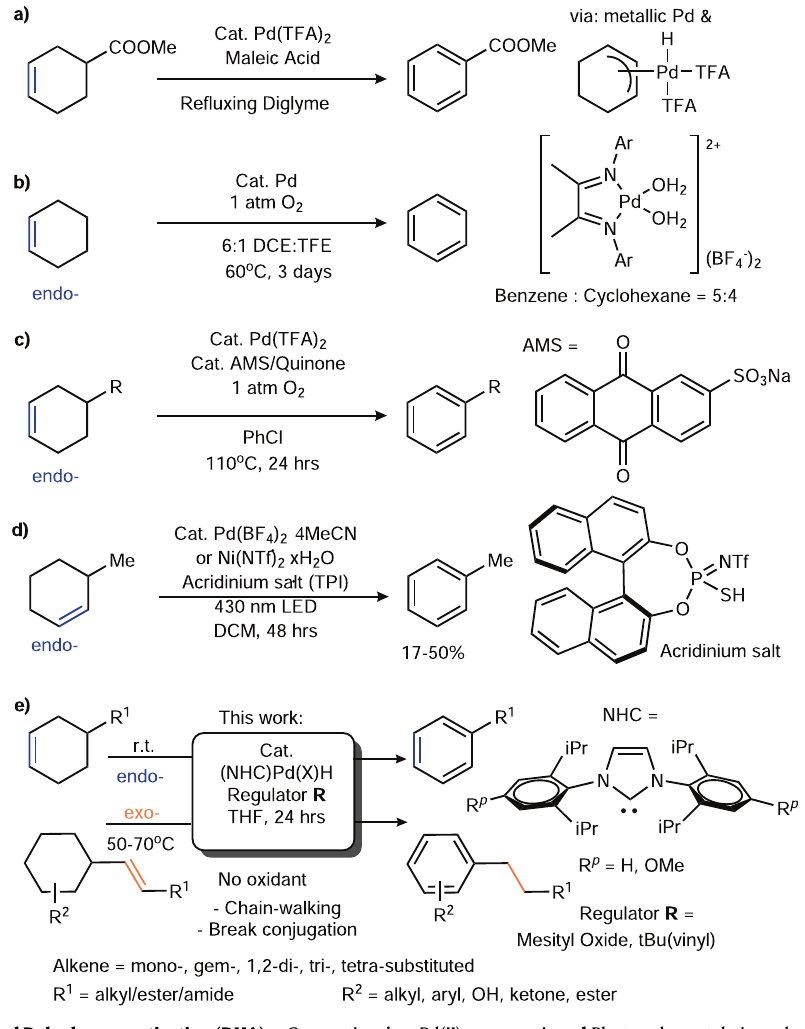
Pd(II) regeneration. d Photoredox catalytic cycles via thiyl radicals. e NHC-Pd-H directed